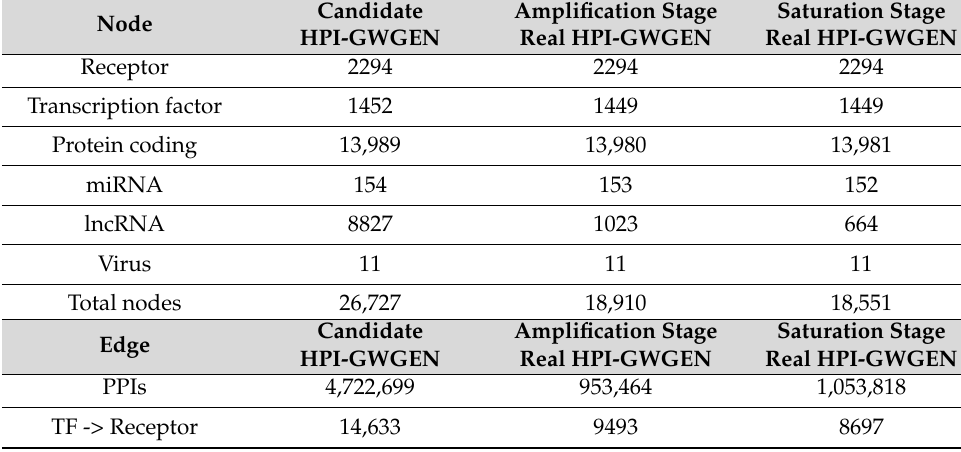
Table 1. The number of nodes and edges in candidate and real HPI-GWGENs at amplification and saturation stages. After system identification and system order detection, the false positives in each node of candidate HPI-GWGEN can be pruned through each infectious stage of HPI RNA-seq data and then form the real HPI-GWGEN of each infectious